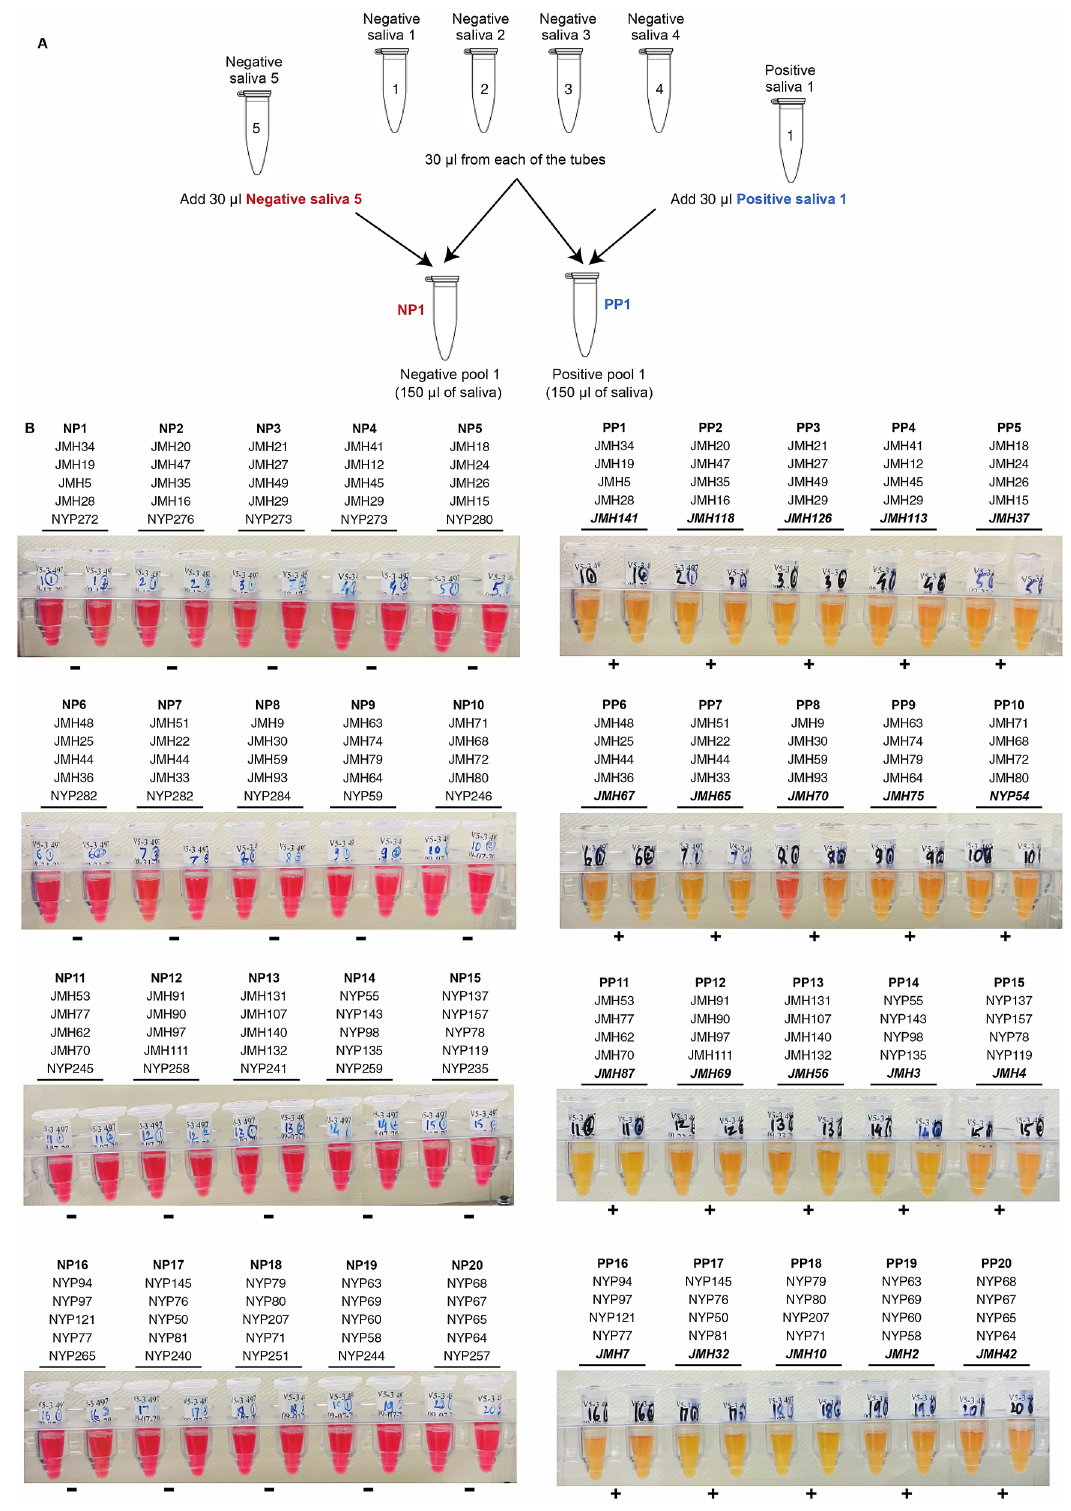
Figure 3. HP-LAMP assay for pooled samples. ( A ) Illustration of the HP-LAMP assay for sample pooling. A negative matrix was created by pooling 4 known negative saliva samples. A positive or negative pool of 5 samples (N = 5) was created by pooling a known positive or negative sample with the negative matrix. ( B ) HP-LAMP testing for pooled saliva samples. 20 positive (n = 20) and 20 negative (n = 20) pools were subjected to HP-LAMP